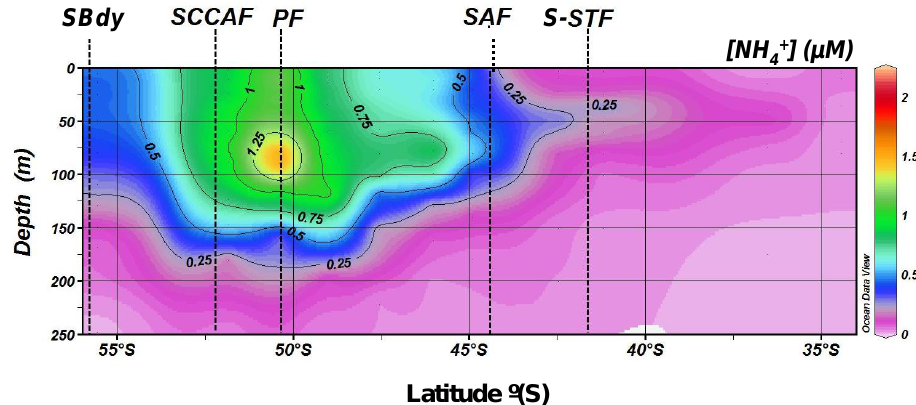
; µM) in the upper 250m along the MD166 BONUS-GoodHope section. Figure 4